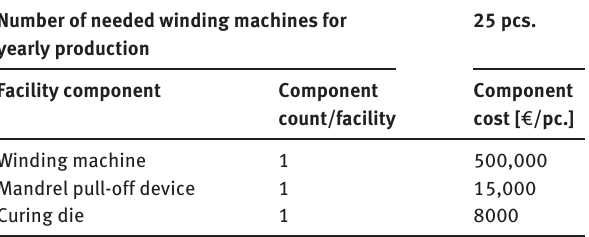
Table 5 Configuration of winding machine and associated facilities for the calculation of machine costs.